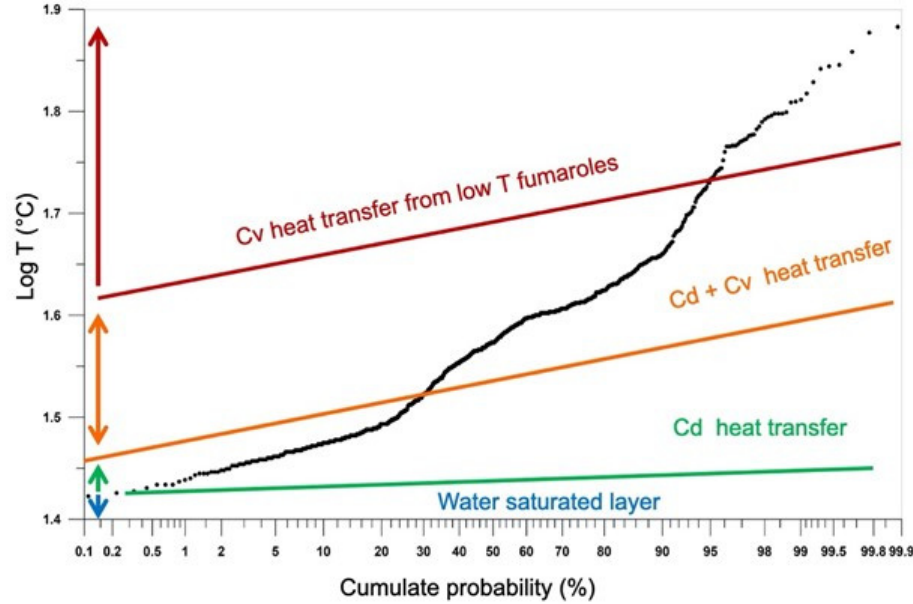
Figure 2. Cumulate probability plot of the measurements by Pyrogips in September 2015. The colored arrows indicate the different ranges of temperature related to different heat transfer processes. Cd represents conductive; Cv represents convective.